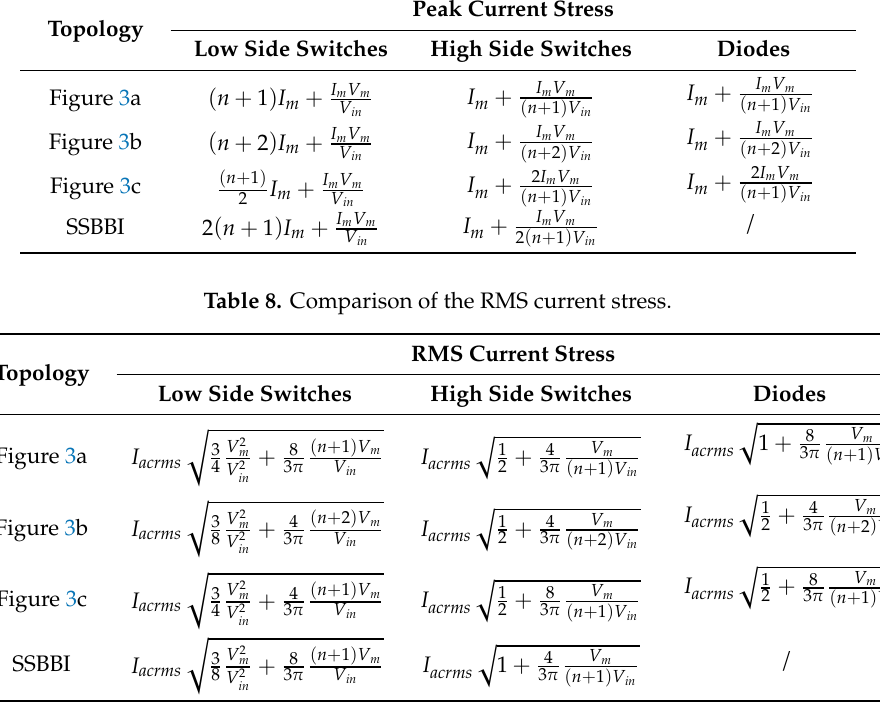
Table 7. Comparison of the peak current stress.